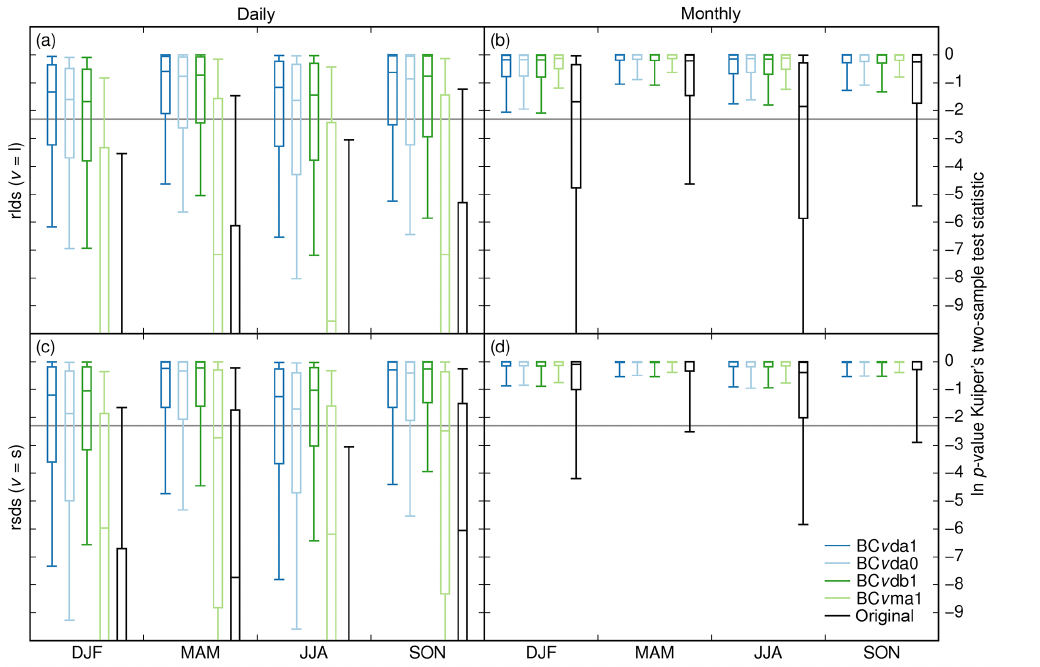
Figure 6. Same as Fig. 5 but based on p values of Kuiper’s two-sample test